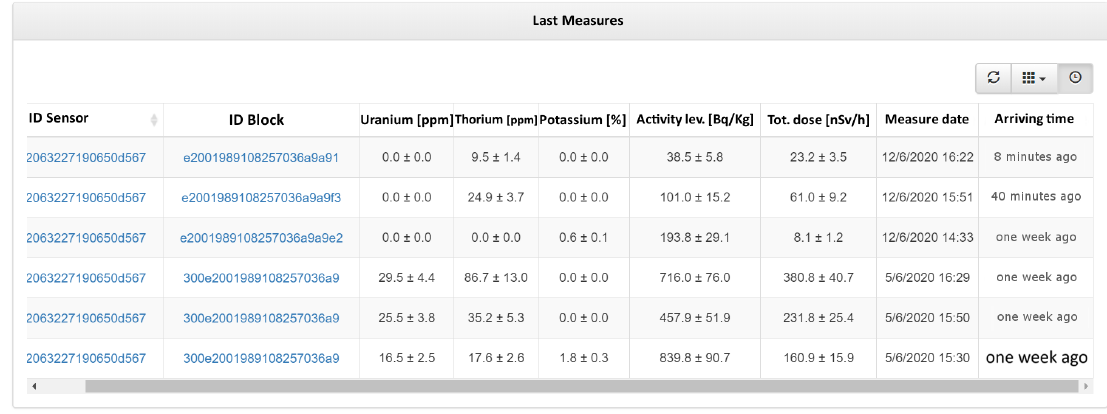
Figure 6. Web-based User Interface of data gateway showing measured material items owed by the